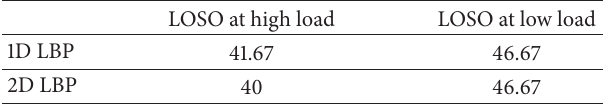
Table 11: The performance of SVM in both schemes when LOSO cross-validation is used.